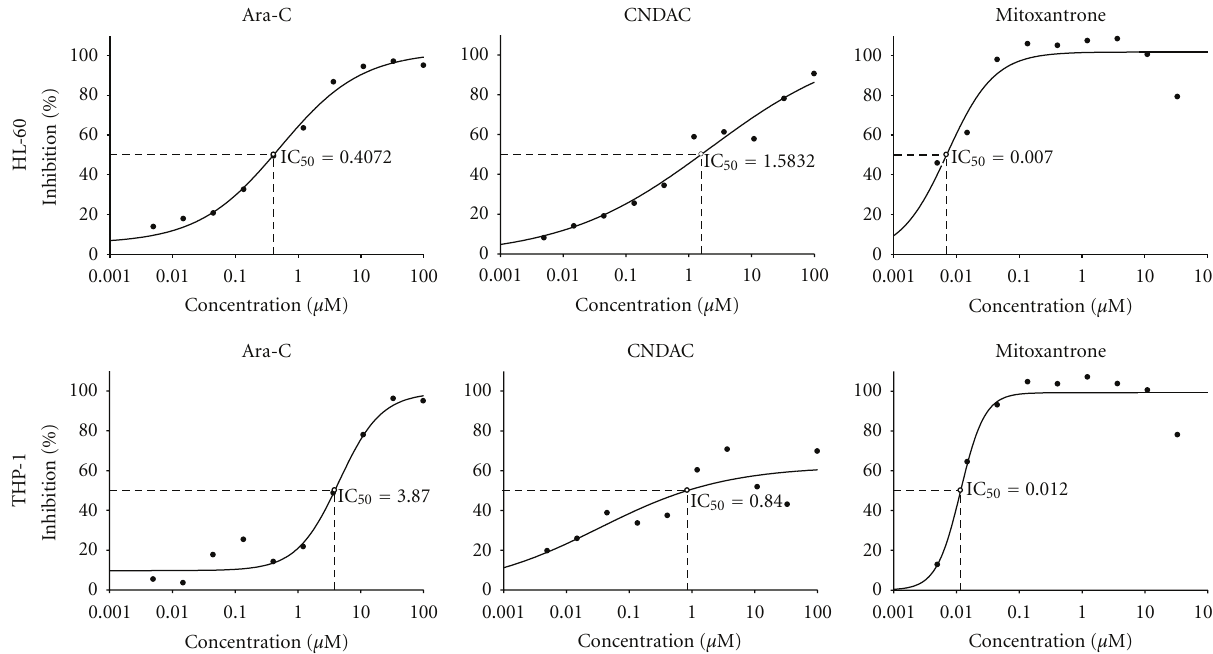
Figure 1: Standard curves and IC 50 values for cell lines ± drug treatment. Plots represent nonlinear regression standard curves and IC 50 values of ara-C, CNDAC, and mitoxantrone for HL-60 (top) and THP-1 (bottom) cells as determined by Alamar Blue assay. Cells were drug- treated for 3 days and absorbance readings-taken 8 hours after addition of Alamar Blue. Inhibition (%) of drugs was calculated from reduc- tion (%) of Alamar Blue. Experiments were run three times, in triplicate each time. Representative plots from one experiment are shown.